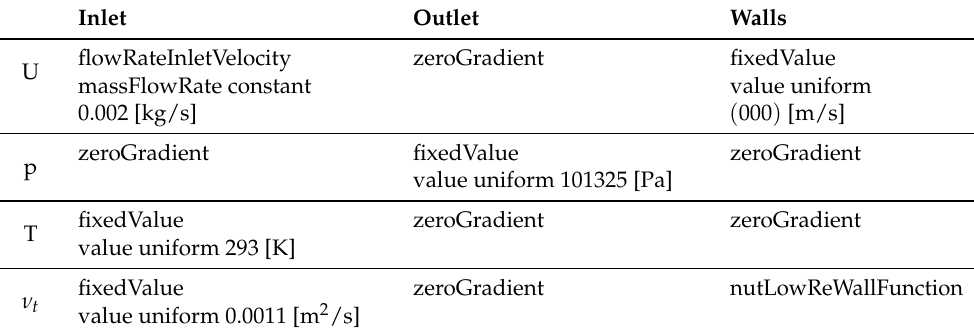
Table 2. Initial and boundary conditions of the numerical